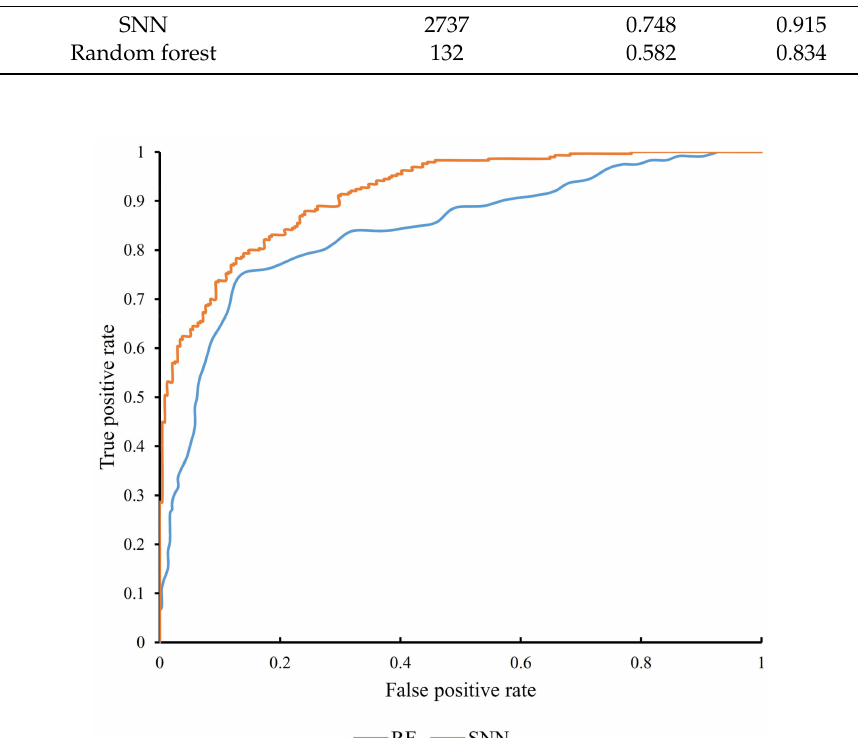
Figure 4. The receiver operating characteristic (ROC) curves for the optimal SNN and Random Forest